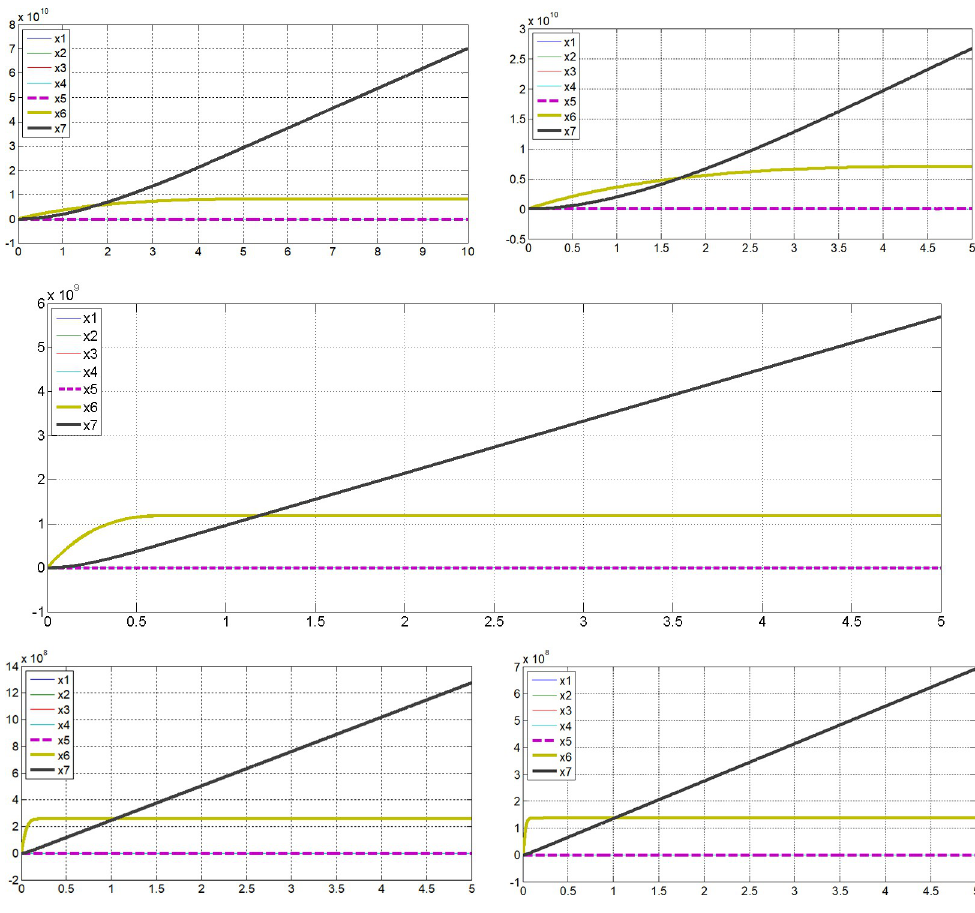
Fig 8. Solutions of differential equations under different values of k